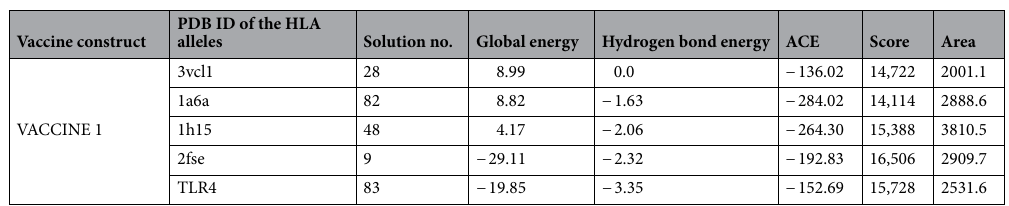
Table 10. Molecular docking results using the PatchDock server. The model was refined further using Firedock server.